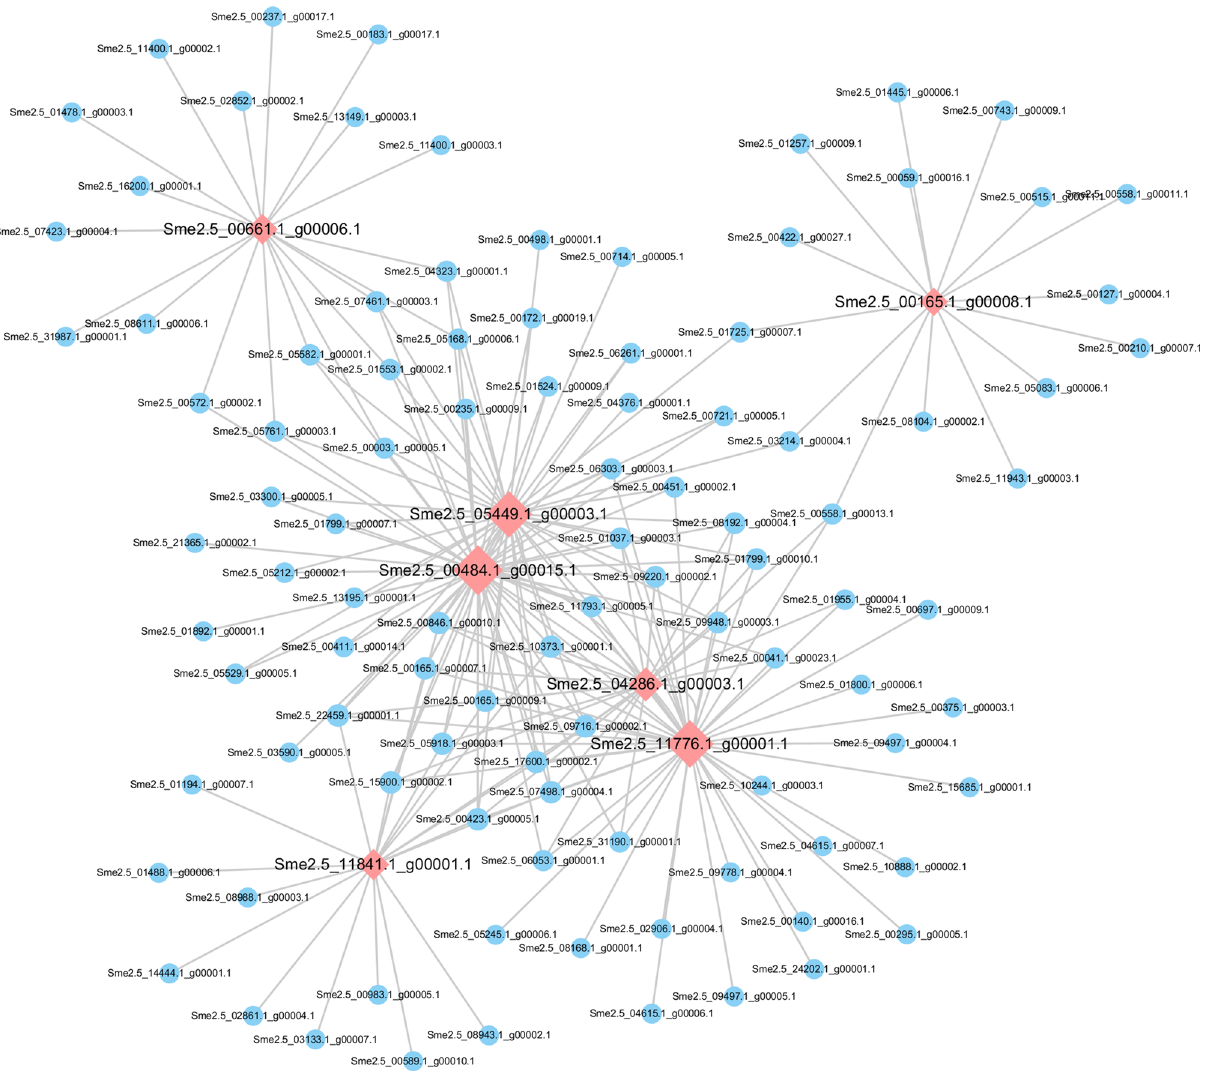
Figure 8. Gene regulatory networks for the KEGG pathway ko00350 (tyrosine metabolism). Cytoscape v3.6.0 (https:// cytos cape. org/) was used to create the